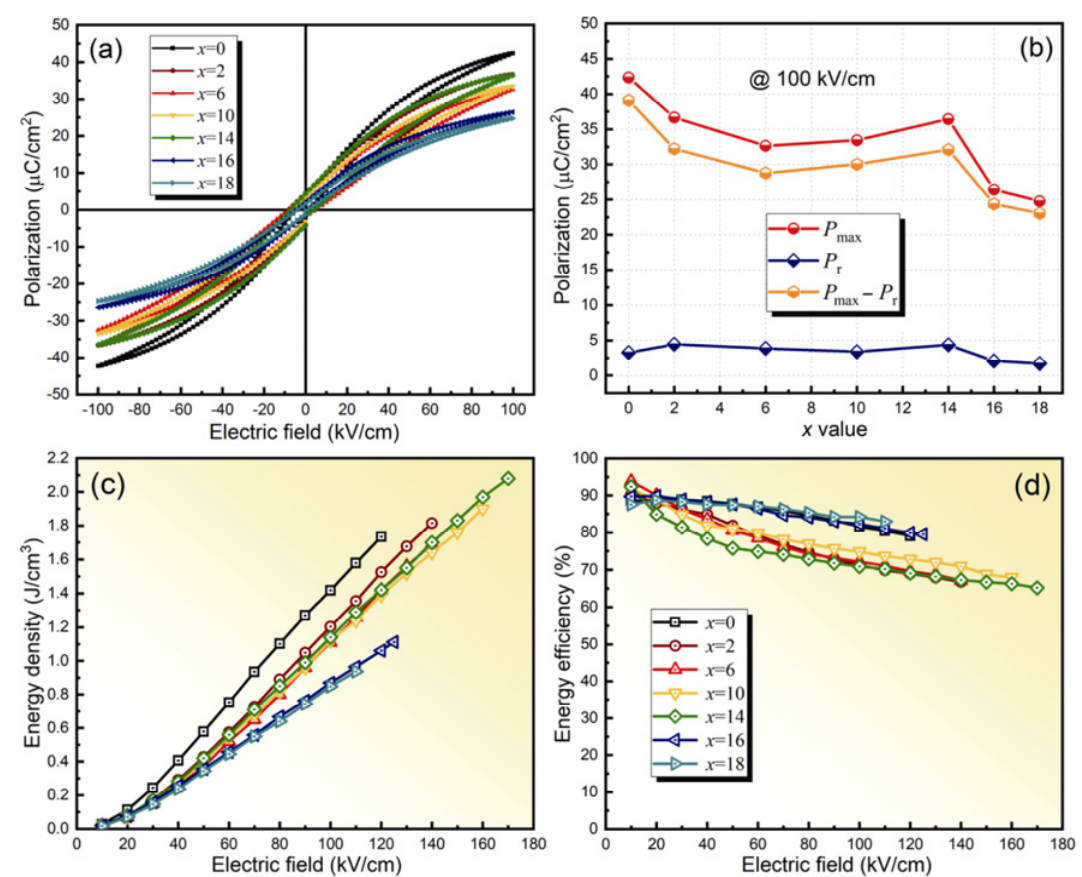
Fig. 6 (a) P–E hysteresis loops of BS 0.5 BNT– x GS ceramic composites and (b) P max , P r , and P max − P r values of BS 0.5 BNT– x GS ceramic composites as a function of x under 100 kV/cm; (c) recoverable energy storage densities and (d) energy storage efficiency of BS 0.5 BNT– x GS ceramic composites as a function of applied electric